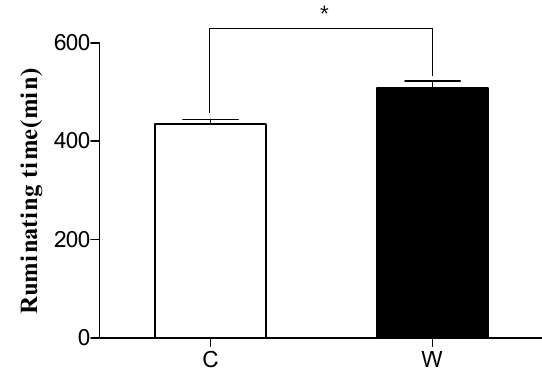
Figure 1. Comparison of ruminating time between conventional farm and welfare farm over 3 days. C, conventional farm; W, welfare farm. * Indicates significant differences between conventional and welfare farms (p<0.01).